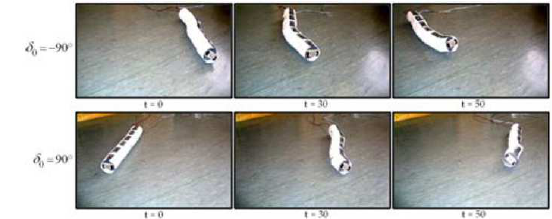
Figure 12: 3D visualization of the simulated gait pat- tern, sidewinding. 0 < t < 10: Locomotion to the left, 10 < t < 25: Counterclockwise rotational motion, 25 < t < 35: Locomotion to the right, 35 < t < 50: Clockwise rota- tional motion, 50 < t < 60: Locomotion to the right.